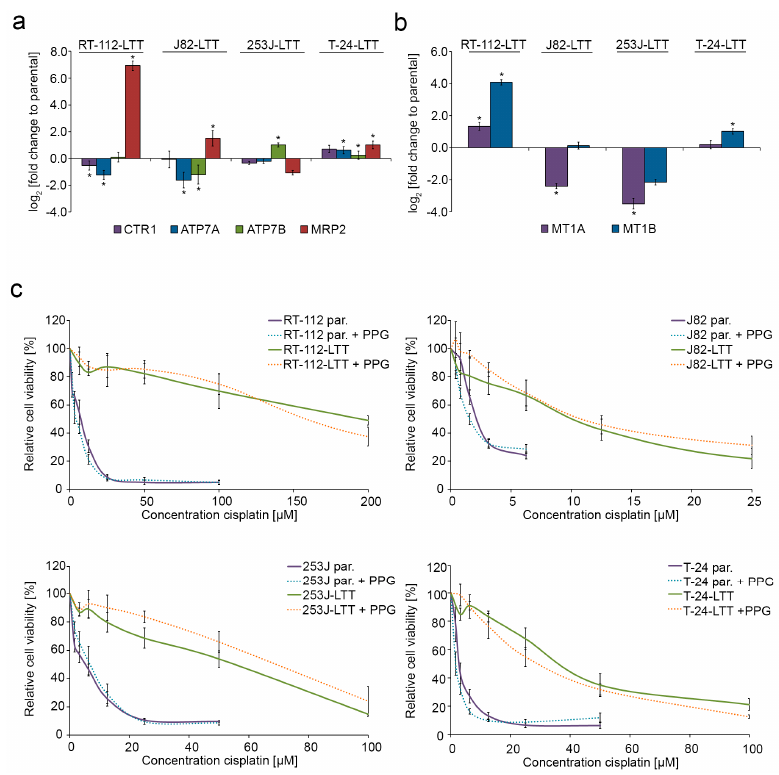
Figure 2. Cisplatin exporter and detoxifying molecules are differentially expressed in LTT lines. Relative fold change of ( a ) CTR1 , ATP7A , ATP7B , MRP2 , ( b ) MT1A and MT1B mRNA expression in RT-112-LTT, J82-LTT, 253J-LTT, T-24-LTT compared to their parental cell lines was measured by qRT-PCR. Expression levels in the untreated parental UCCs were set as 1. For endogenous expression data of parental UCCs see Figure S1a,b. SDHA was used as a reference gene and relative expression was calculated by the 2 −ΔΔ C t method. * p < 0.05. ( c ) After concomitant treatment with DL -propargylglycine (PPG) and cisplatin for 72 h, viability was measured by MTT assay in parental UCCs and LTTs. Untreated cells were set as 100. Values represent the mean ± SD of two independent experiments.